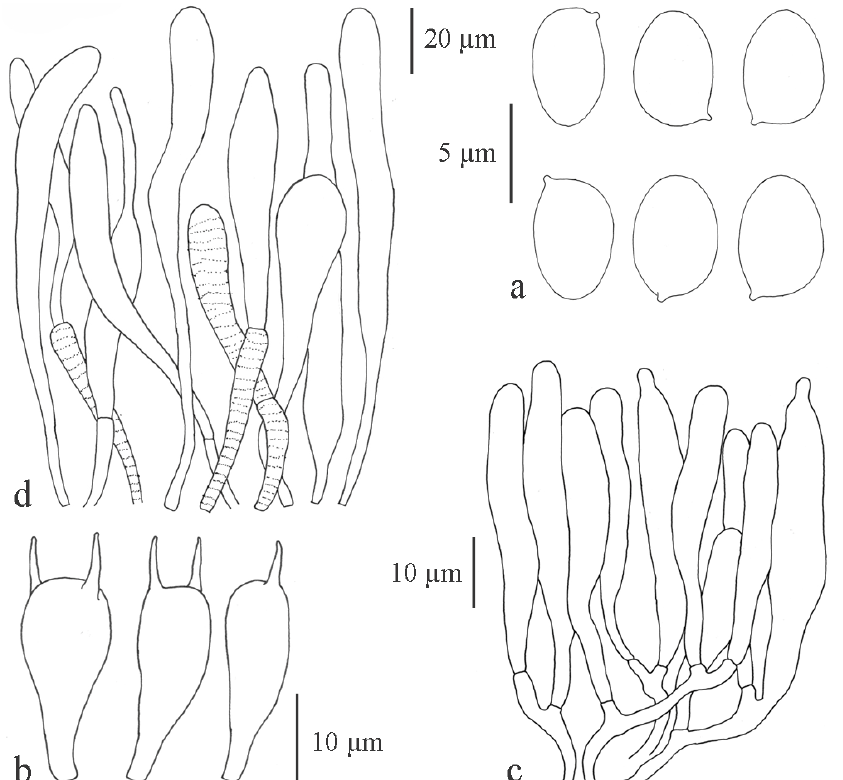
Figure 10. Microcharacters of Chlorophyllum hortense (MFLU 12-1783). ( a ) basidiospores. ( b ) basidia. ( c ) cheilocystidia. ( d ) pileus covering.